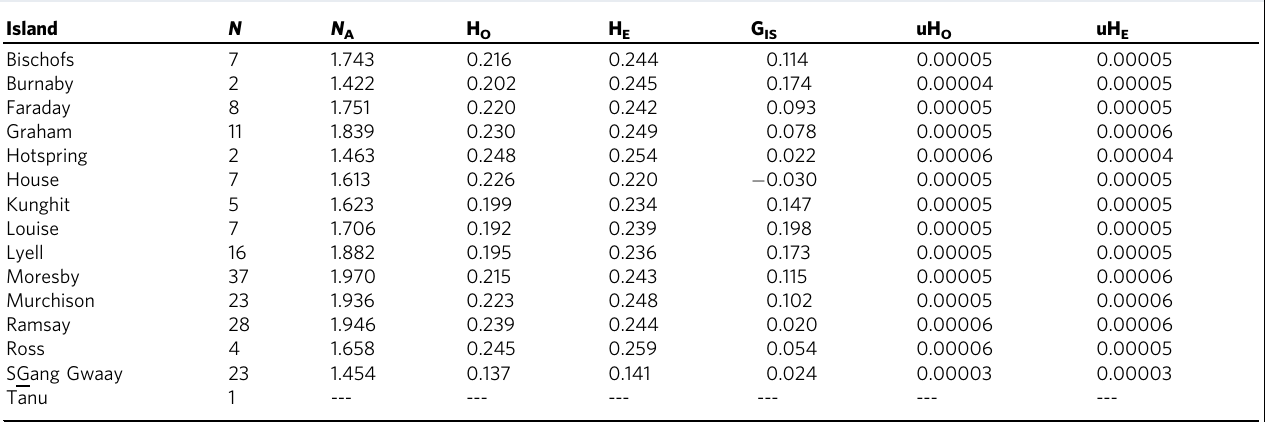
Table 1 Genetic diversity by island for Sitka black-tailed deer. Island